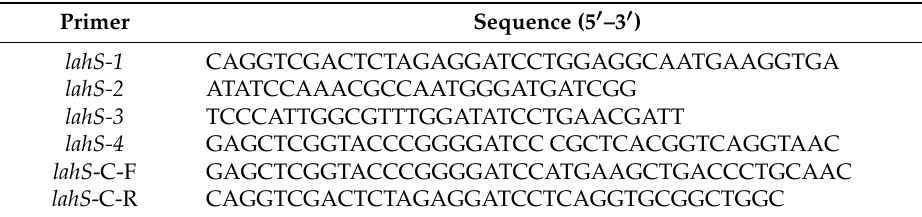
Table 4. Primers used for construction of lahS mutant and complemented